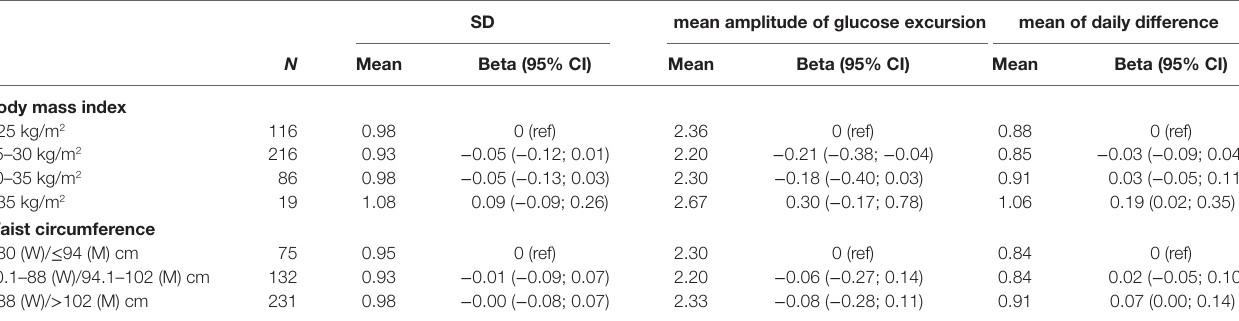
TaBle 3 | Associations of measures of adiposity and indices of glycemic variability in the meta-analyses.